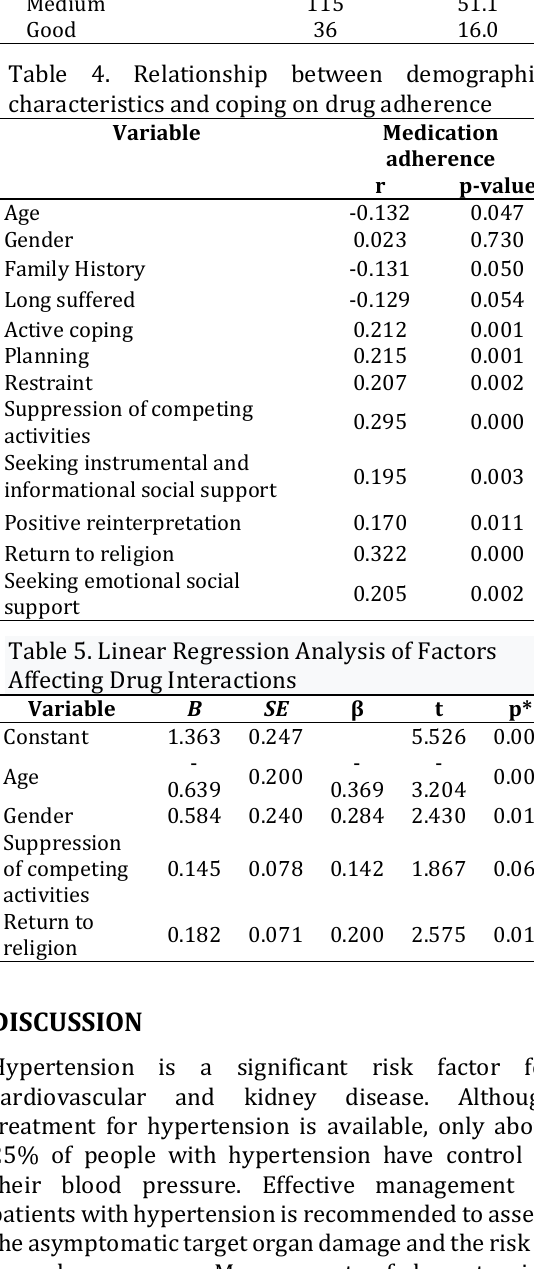
Table 3. Drug Adherence (n = 225) Variable Drug Adherence